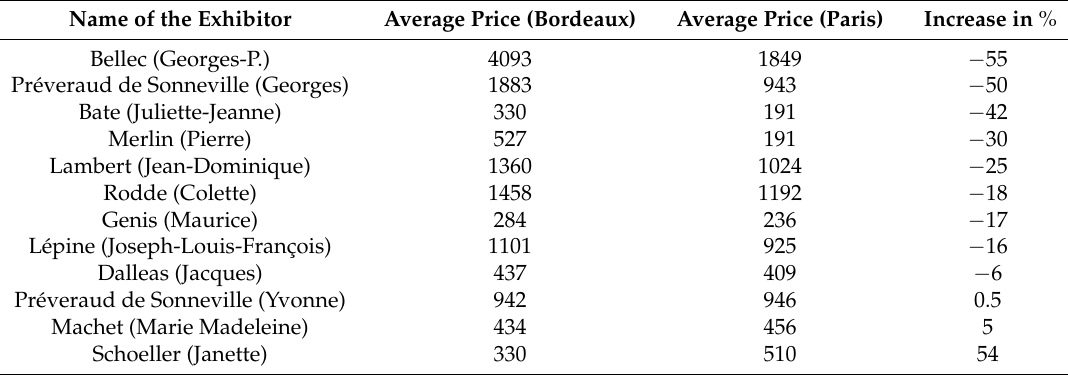
Table A2. Increase in the average sale price (in constant 1928 francs) made by the AIB exhibitors who moved from Bordeaux to Paris. Name of the Exhibitor Average Price (Bordeaux) Average Price (Paris) Increase in % Bellec (Georges-P.)